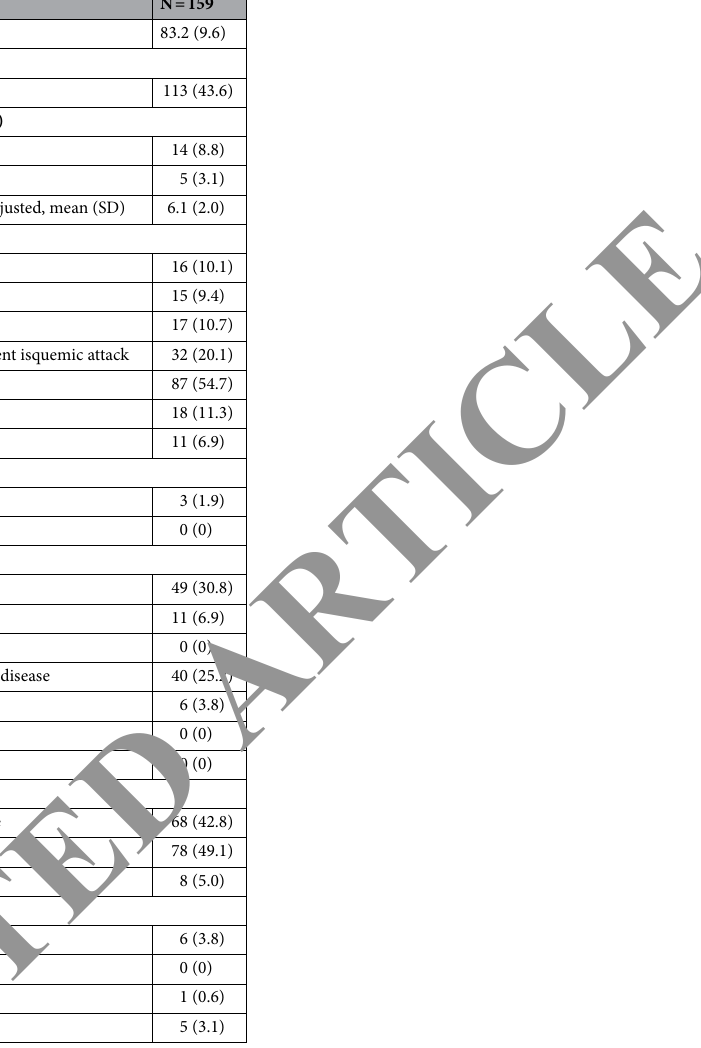
Table 1. Demographic and clinical characteristics of total population. AIDS: acquired immune deficiency syndrome; COPD: chronic obstructive pulmonary disease; SD: standard deviation.